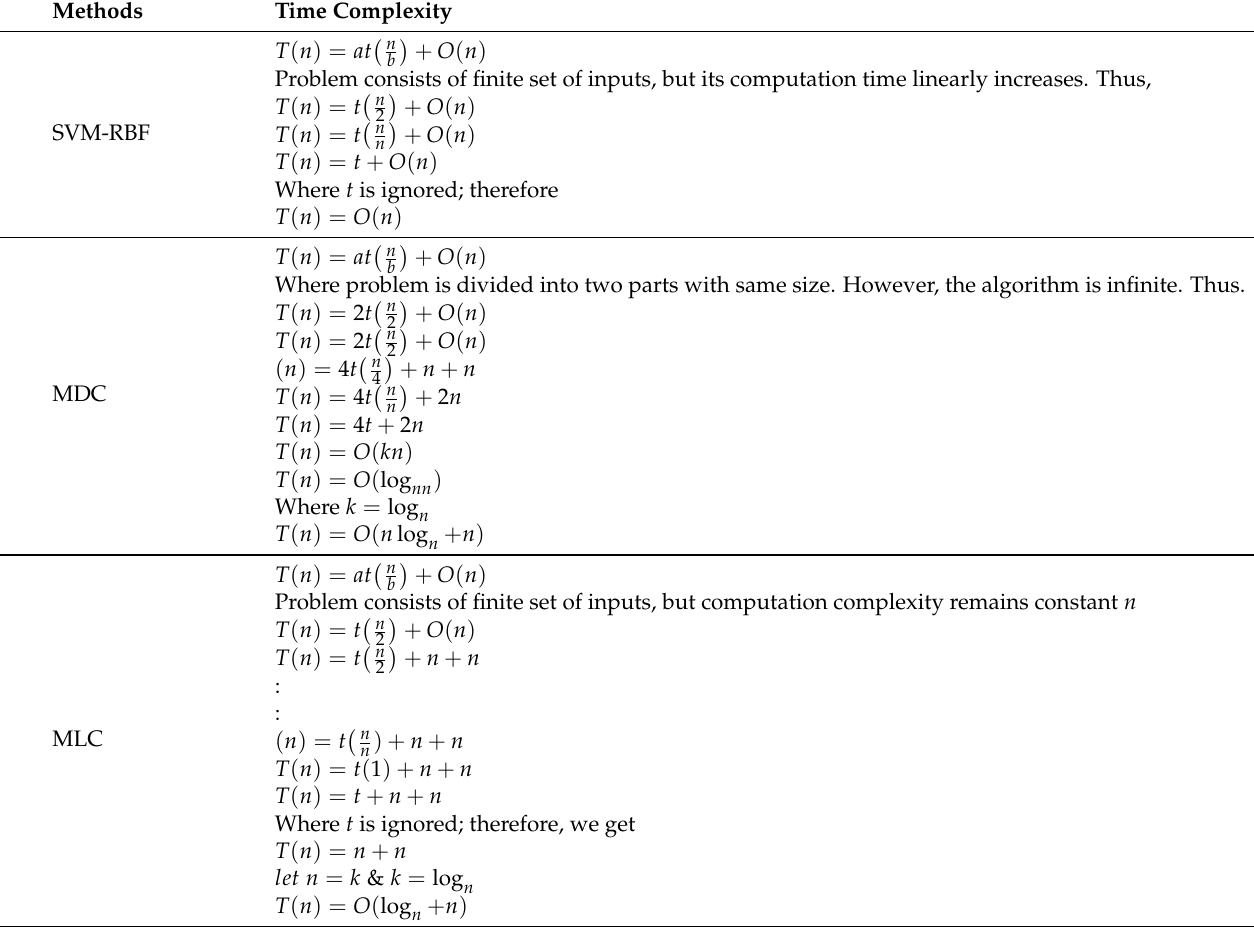
Table A1. Time complexity for contending